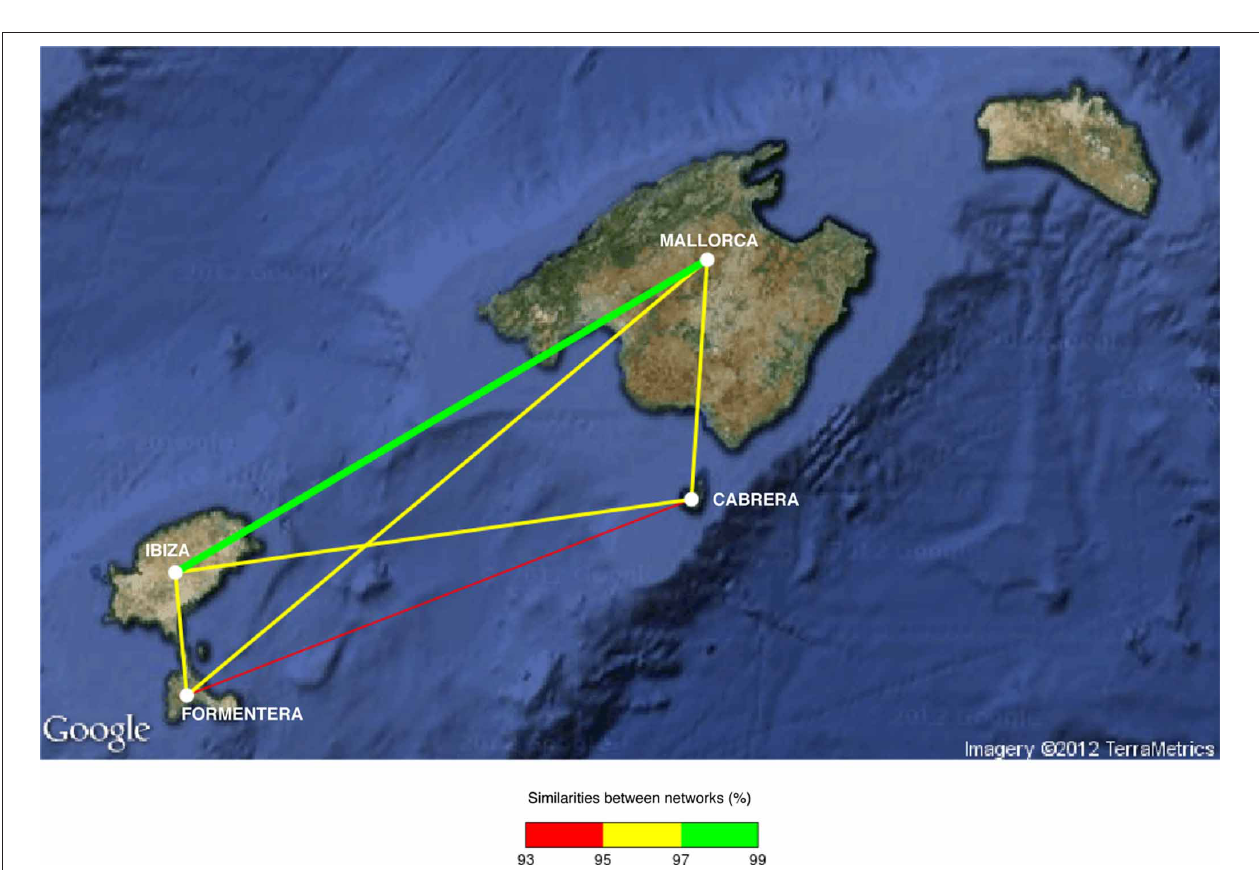
FIGURE 3 | Bipartite network analysis of endophytic bacterial community of P. oceanica tissues among islands. The nodes represent the islands. Thicker edges between two islands indicate larger similarity of the bipartite networks. Edges are also color-coded to indicate the percentage of similarity between two